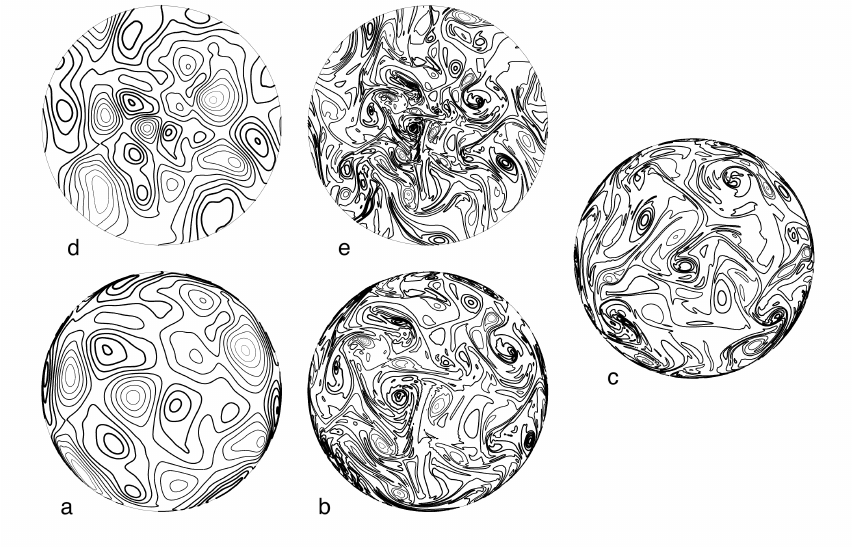
Figure 3. Stream function, ( a , d ), and vorticity, ( b , c , e ), at time t = 2.0 in a non-rotating, viscous experi- ment in which the initial energy is confined to spherical harmonic degrees n = 16,17,18. ( a , b ) are polar views, as seen by an observer at z = ∞ , above the north pole. ( d , e ) are northern-hemisphere stereographic views that depict the same field as the polar views directly below. Compared to the polar views ( a , b ), the stereographic views ( d , e ) are relatively free of distortion. Panel ( c ) is an equatorial view, as seen by an observer at x = ∞ . In all views, darker contour lines correspond to larger